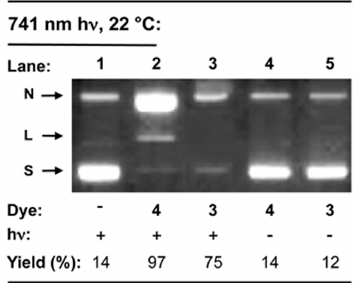
Figure 2. Ethidium bromide stained 1.5% agarose gel showing photo-cleavage of pUC19 plasmid DNA upon irradiation with a 741-nm LED lamp (0.3 W/cm 2 ; spectral output 707–759 nm). Reactions contained 10 mM sodium phosphate buffer pH 7.0 and 38 µM bp DNA in the absence and presence of 25 µM of dyes 4 and 3 (60 min h ν at 22 °C). Parallel control reactions containing dye were kept in the dark (lanes 4 and 5 ). Abbreviations: L, linear; N, nicked; S, supercoiled.